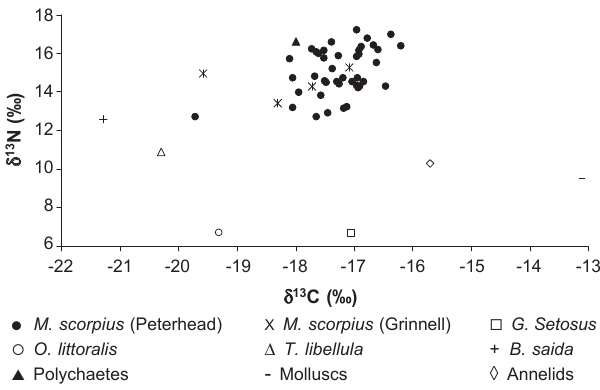
Fig. 5. – Carbon and nitrogen stable isotope values of Myoxocephalus scorpius and diet items collected from Peterhead Inlet and the estuary of the Sylvia Grinnel River.